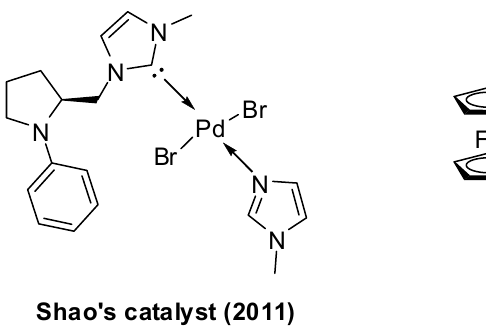
Figure 1. Shao’s (left) and Wu’s (right) catalysts applied in the synthesis of aromatic ketones by Pd-catalyzed coupling of arylboronic acids with